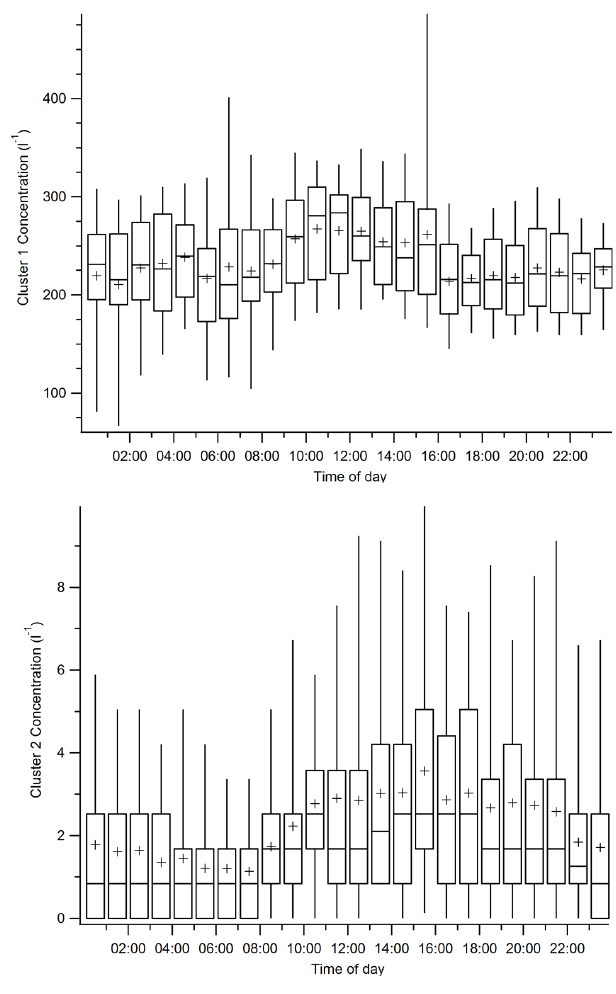
Fig. 9. Diurnal average number concentration of clusters 1 (top) and 2 (bottom) for the NE air mass time period. Mean values denoted with +